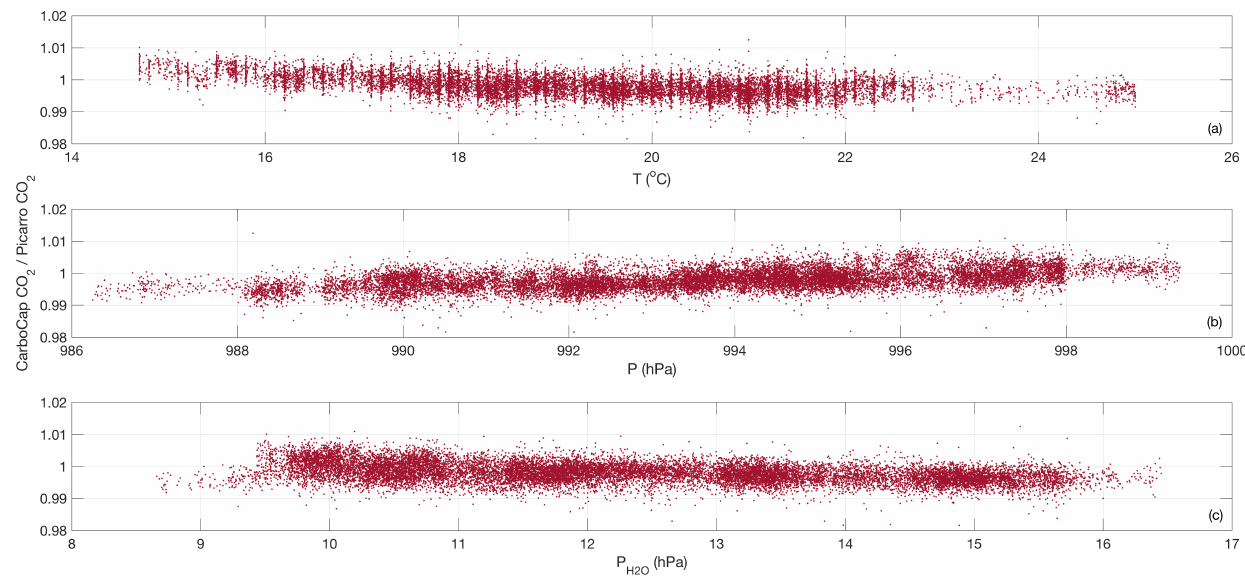
Figure 6. Ratio of 1min mean CO 2 dry air mole fractions presented in Fig. 5, shown as a function of temperature (a) , pressure (b) , and the partial pressure of water (c) .